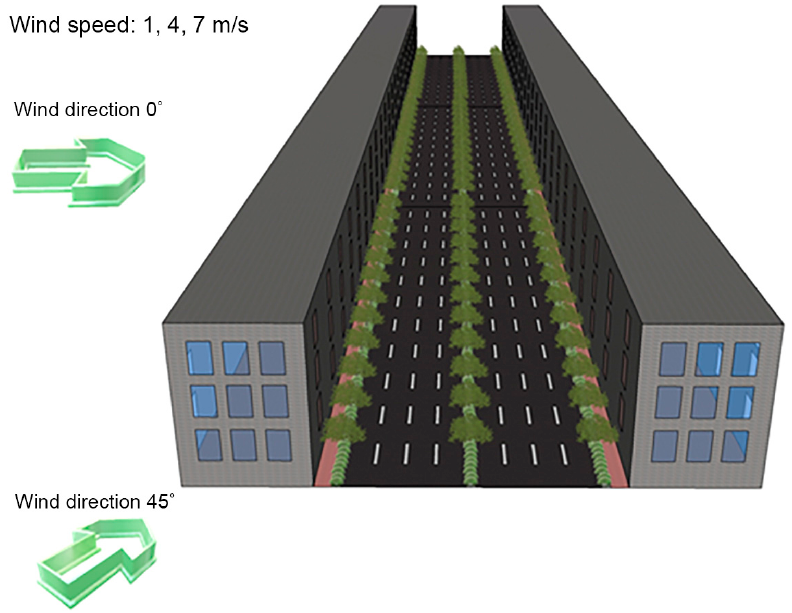
Figure 7. Illustration of the wind velocity and direction in the computational fluid dynamics (CFD) simulation model.